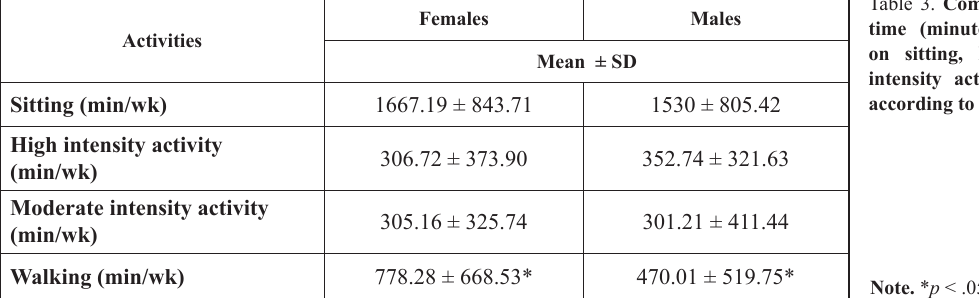
Table 3. Comparison of means of time (minutes per week) spent on sitting, high and moderate intensity activities, and walking according to gender